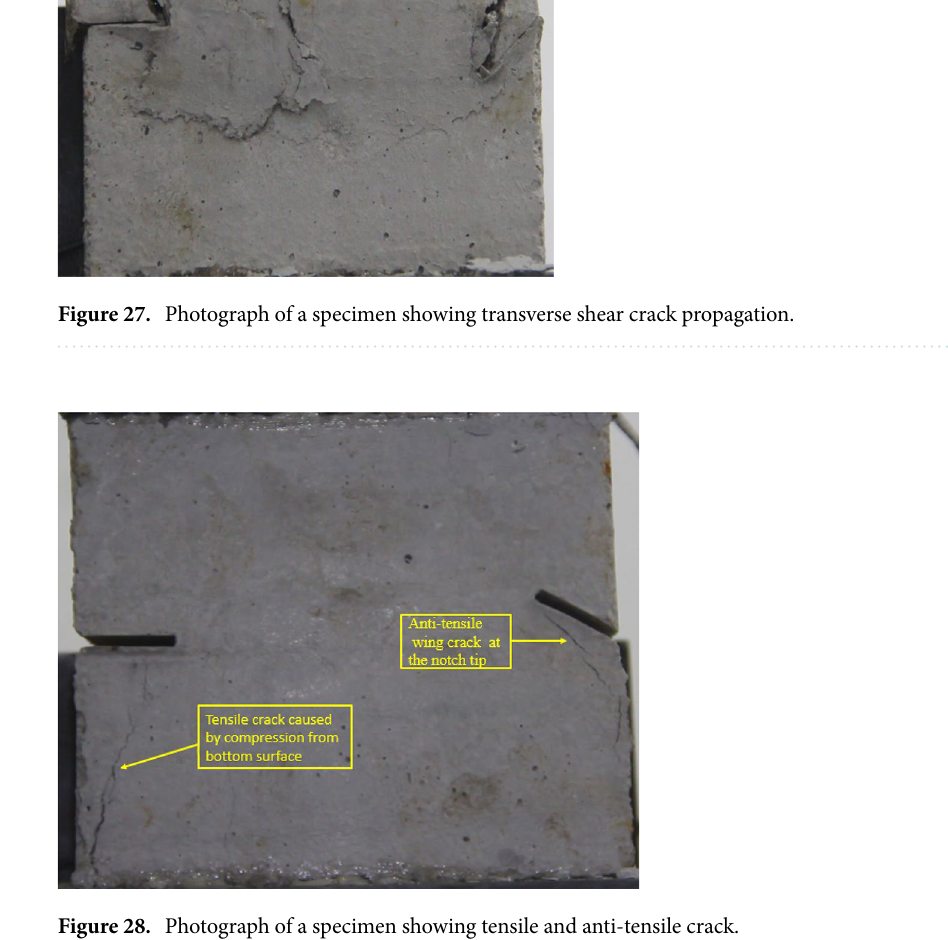
Figure 28. Photograph of a specimen showing tensile and anti-tensile